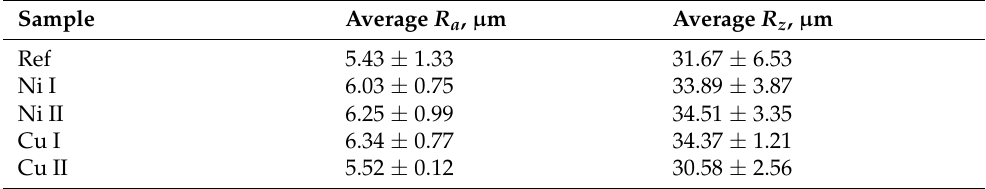
Table 4. Results of surface roughness analysis in terms of the R a and R z